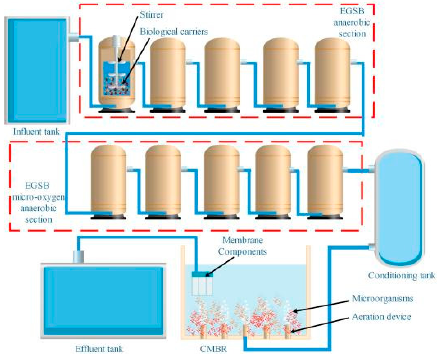
Figure 1. Schematic diagram of EGSB-CMBR.